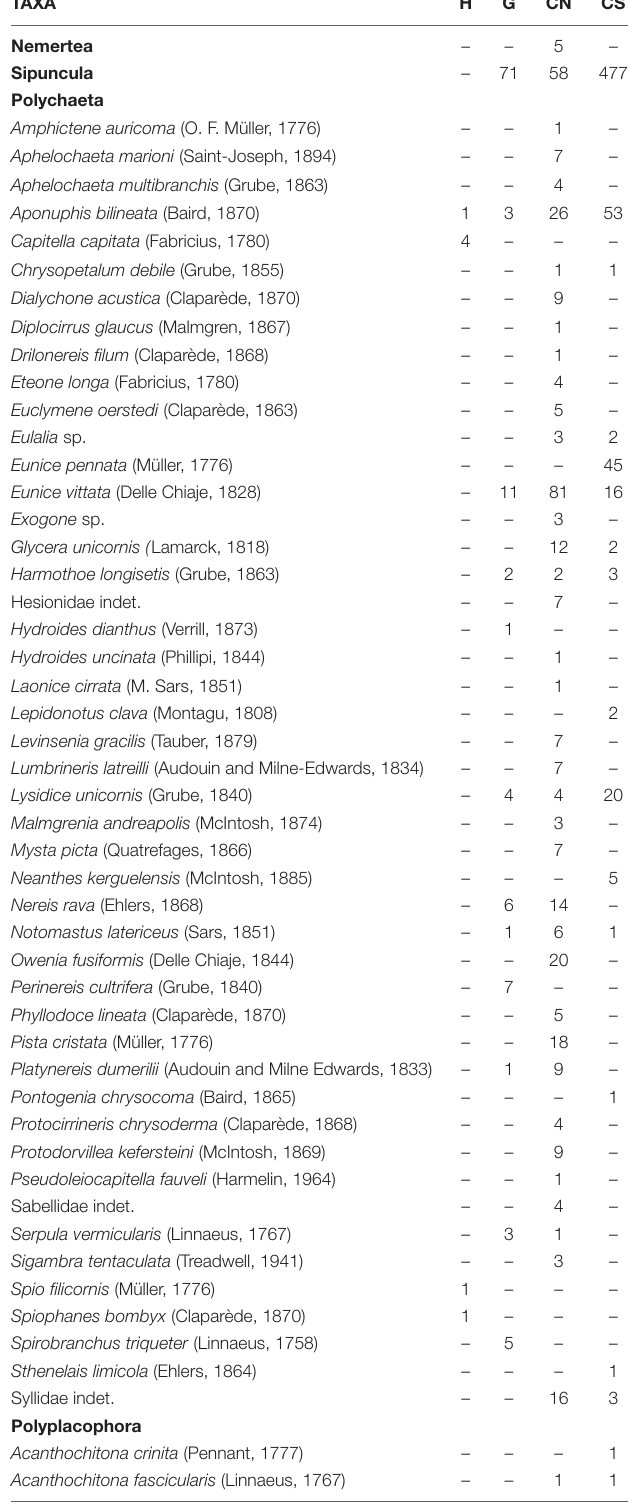
TABLE 3 | Taxonomic list of total fauna occurring at Secca delle Fumose, with abundance (N) of each taxon at each site (H - White hydrothermal vent; G - Geyser; CN - Control North; CS - Control